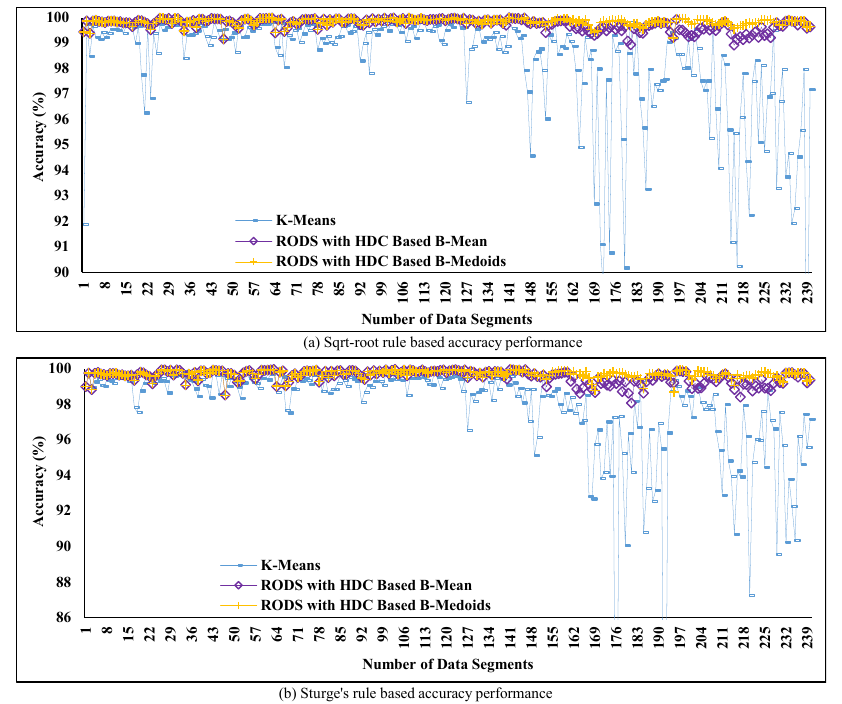
Figure 15. Performance comparison of proposed RODS with HDC-based B-means and B-medoids with conventional K-means versus the number of data segments over time. ( a ) Accuracy versus square-root rule (K = 11); ( b ) accuracy versus Sturge’s rule (K =